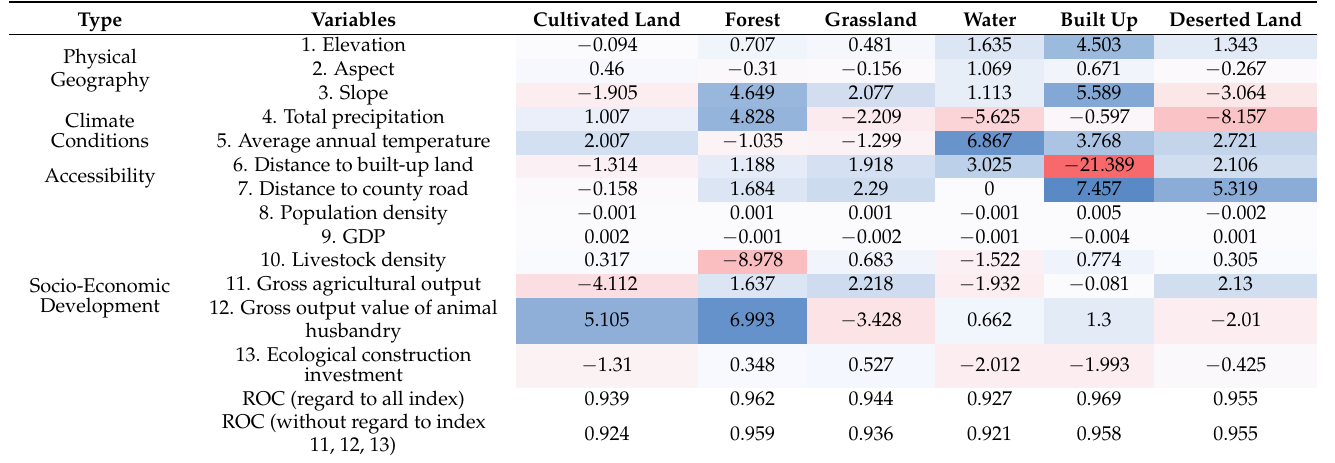
Table 5. Logistic regression model for each land